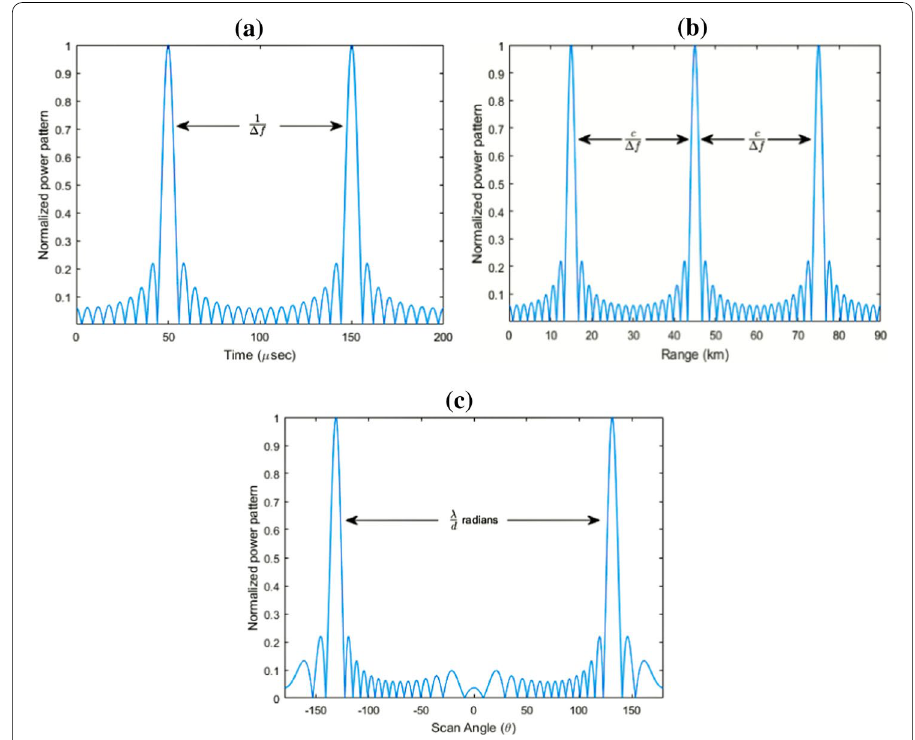
Fig. 6 FDA beampattern periodicity. a Time periodicity. b Range periodicity. c Angle